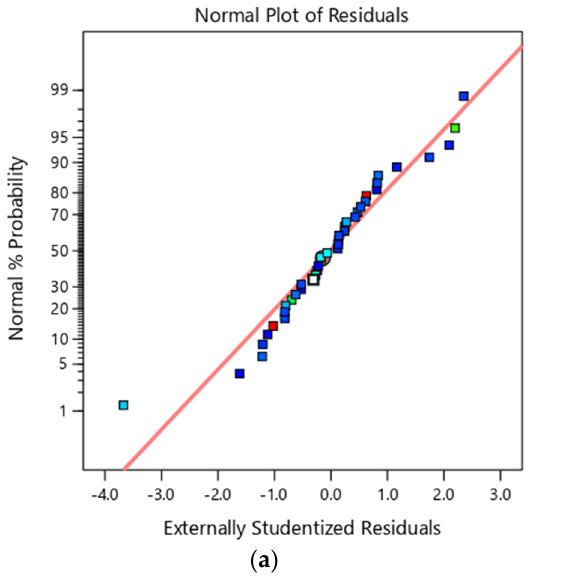
Figure 2. ( a ) Normal probability plot of the externally studentised residuals for the D-flow fitted model, and ( b ) plot of the externally studentised residuals versus D-flow predicted values.